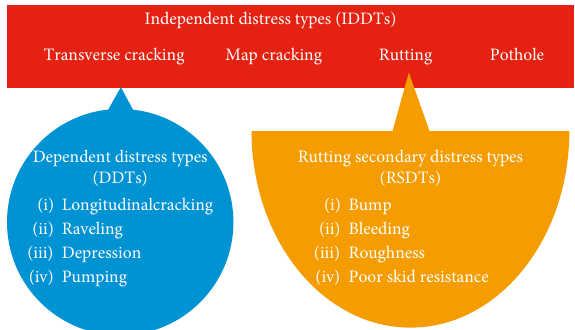
Figure 9: Distress-type system of asphalt